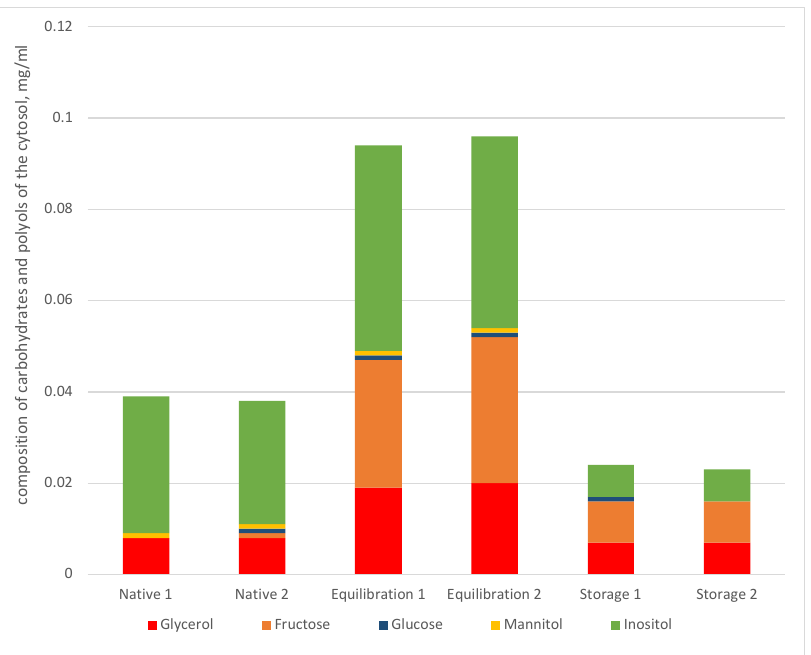
Figure 5. Carbohydrate and polyol composition of the cytosol of rooster spermatozoa depending on technological factors (native semen, equilibration, storage for 3 h) in duplicate.